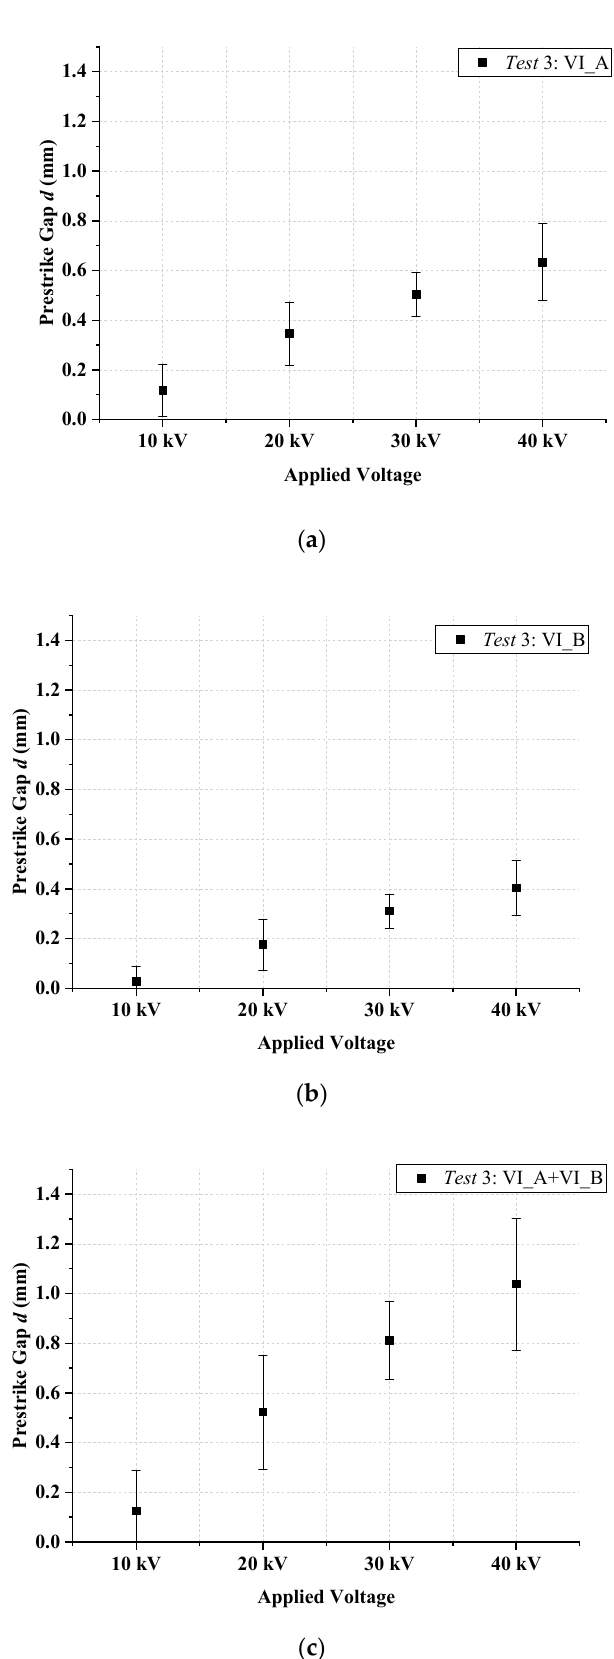
Figure 9. The relationships between d 50 and applied voltage U s in Test 3: VI_A ( a ), VI_B ( b ), and the total prestrike gaps ( c